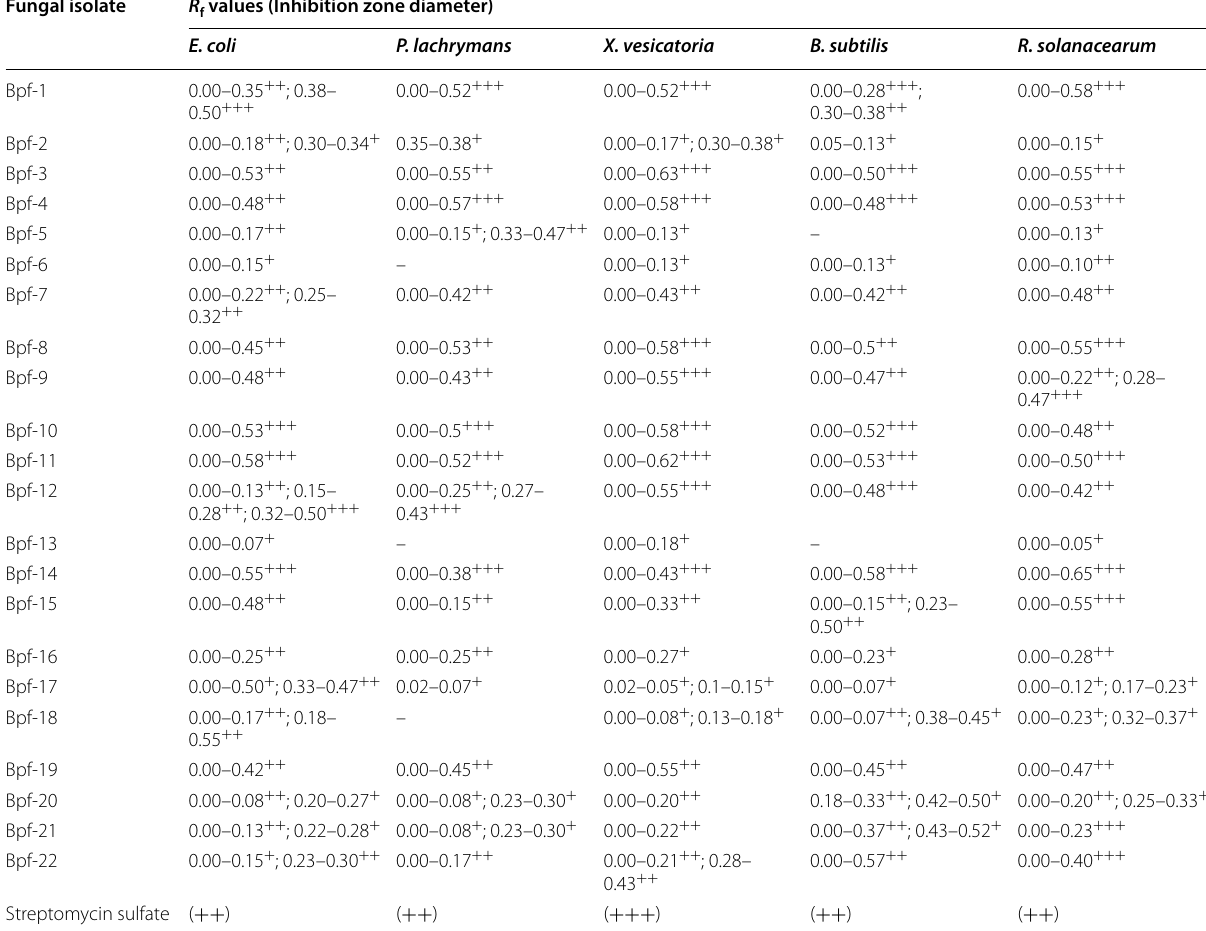
Petroleum ether and acetone (4:1, V/V) were used as the solvent for TLC. The data presented in the table are the R f values of the antibacterial activity; –, an inhibition zone was not observed; , the inhibition zone diameter ranged from 0 to 5 mm; + diameter was greater than 10 mm; the positive control streptomycin sulfate was only sampled on the TLC